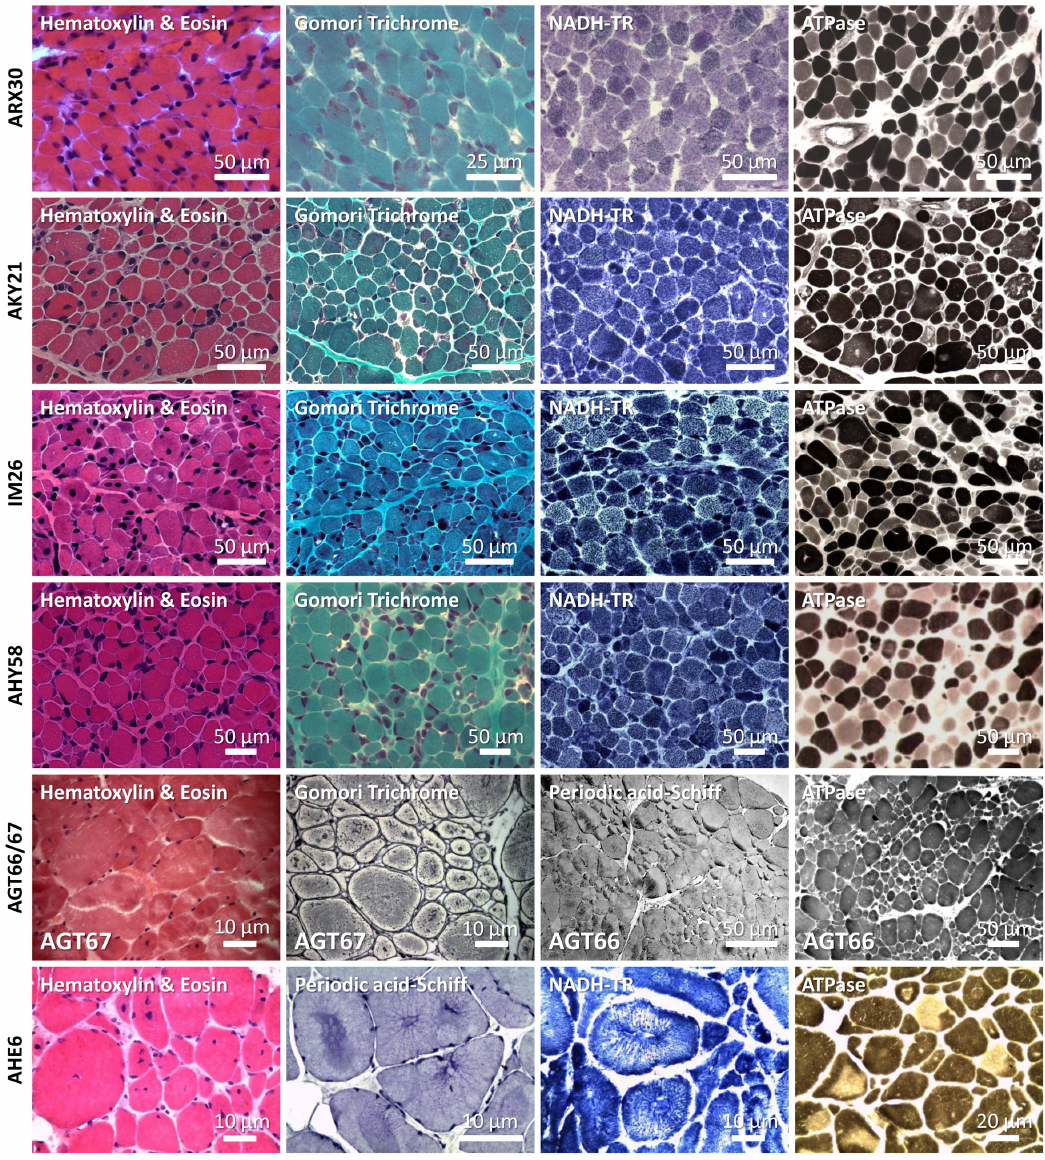
Figure 2. Histological analysis of muscle biopsies from patients ARX30, AKY21, IM26, AHY58, AGT66/AGT67, and AHE6. The deltoid muscle biopsy of patient ARX30 was performed 2 days after birth and revealed nemaline bodies, fiber size variability and type I fiber predominance. On the deltoid muscle biopsies from AKY21 and IM26 (shortly after birth), nuclear internalization, atrophy, fiber size variability, and areas devoid of oxidative enzyme activity became apparent. Analysis of the deltoid muscle biopsy of patient AHY58 (20 days) demonstrated fiber size variability, atrophy, internal nuclei, and discrete areas of reduced oxidative enzyme activity. Biceps brachii biopsy from AGT66 (8 years) and AGT67 (shortly after birth) revealed nuclear internalization, fiber size variability, multiple minicores devoid of oxidative enzyme activity and type I fiber predominance. Left deltoid muscle biopsy from patient AHE6 (performed at 30 years) revealed internalized nuclei, fiber size variation, radial arrangements of sarcoplasmic strands, necklace fibers, type I fiber predominance, core-like structures, fibrosis and fatty infiltrations.